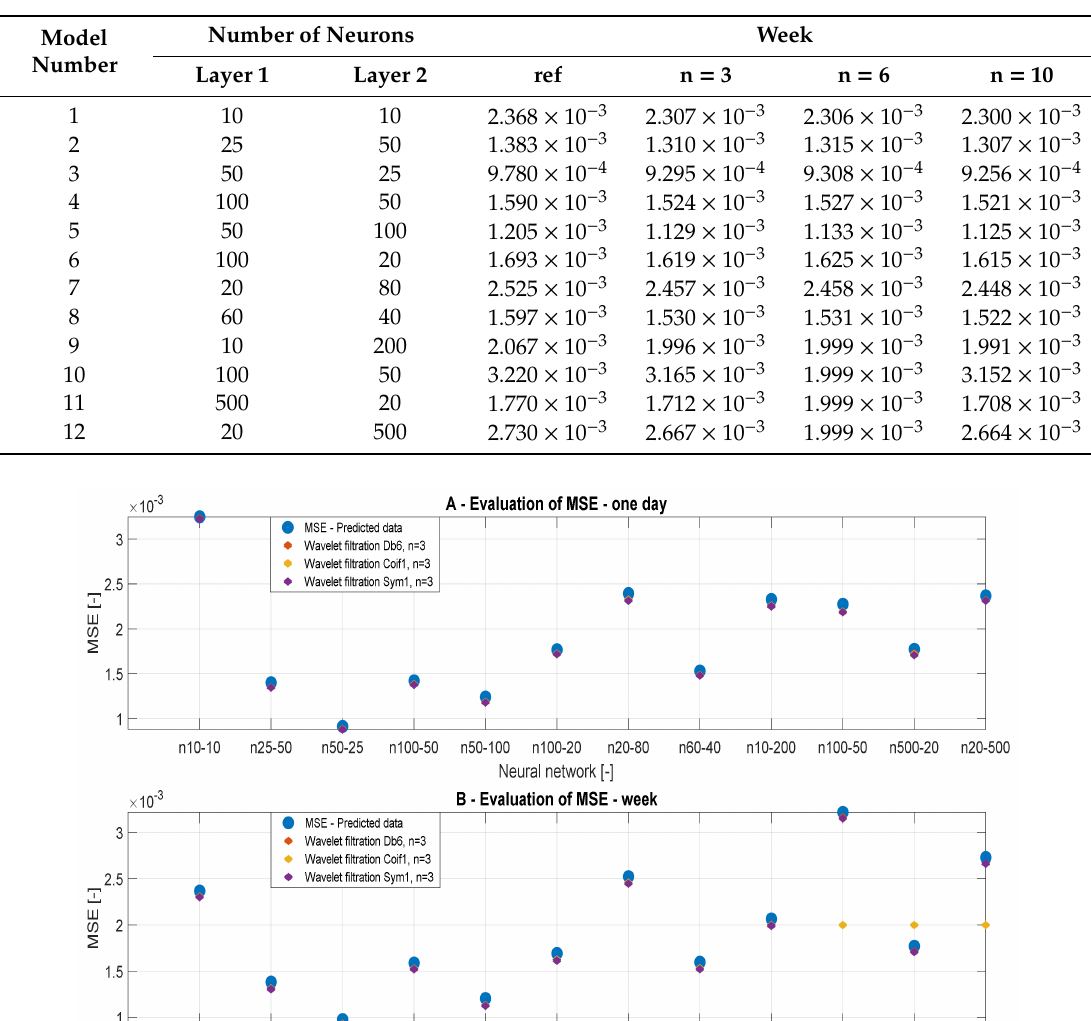
Table 9. MSE values for the reference signals and wavelet-based filtered signals. Model